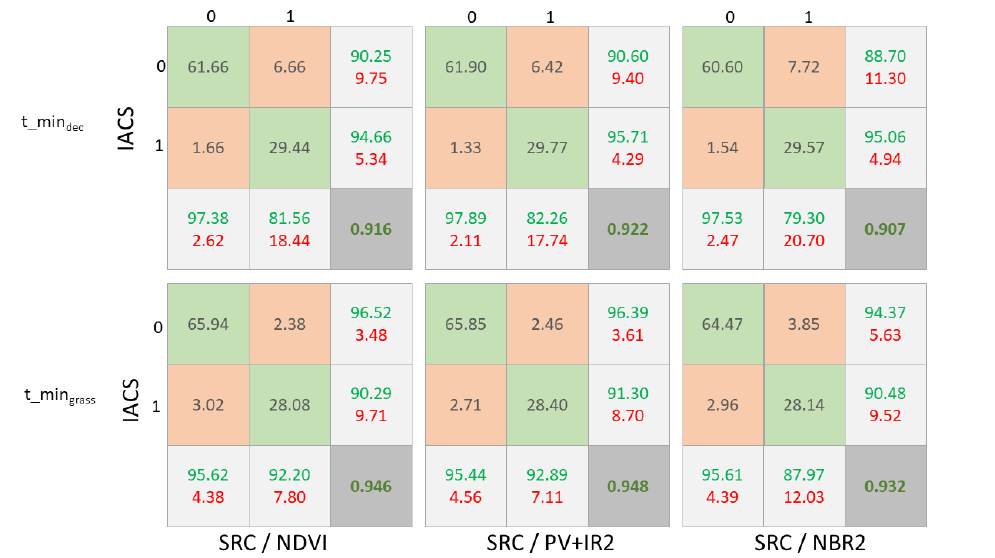
Figure 9. Validation of the SRC bare soil mask using the European IACS data. Results are presented as a confusion matrix; numbers are given in (%) except for the overall accuracy (dark grey field). The overall accuracy for all index/ t _ min versions is >0.9 for all six SRCs. The t _ min grass versions have higher accuracies than t _ min dec for all versions. Most important are the matrix values of the middle quarter at the bottom that summarizes the percentage of SRC pixels also covered by the IACS mask (TN as the green number). In the same box, the percentage of SRC pixels not covered by the IACS mask is listed (FN as the red number). While